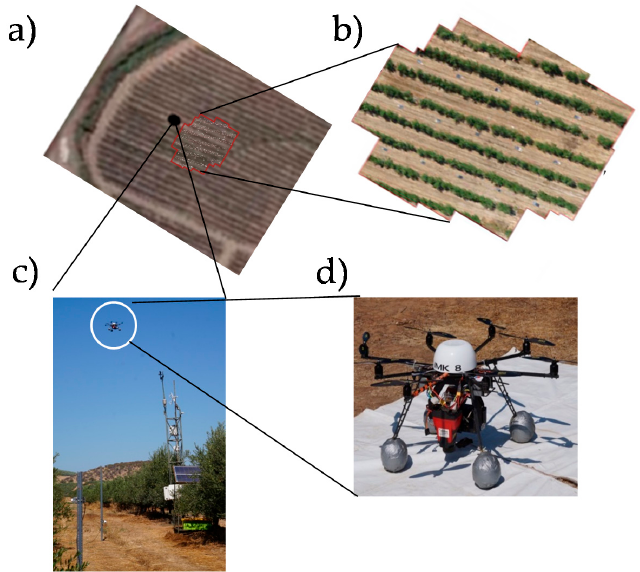
Figure 1. Experimental Site showing: ( a ) the location of eddy correlation (EC) system; ( b ) experimental site; ( c ) helicopter-based unmanned aerial vehicle (UAV) equipped with multispectral and infrared thermal cameras flying over an EC system installed over a drip-irrigated olive orchard; and ( d ) helicopter-based UAV.